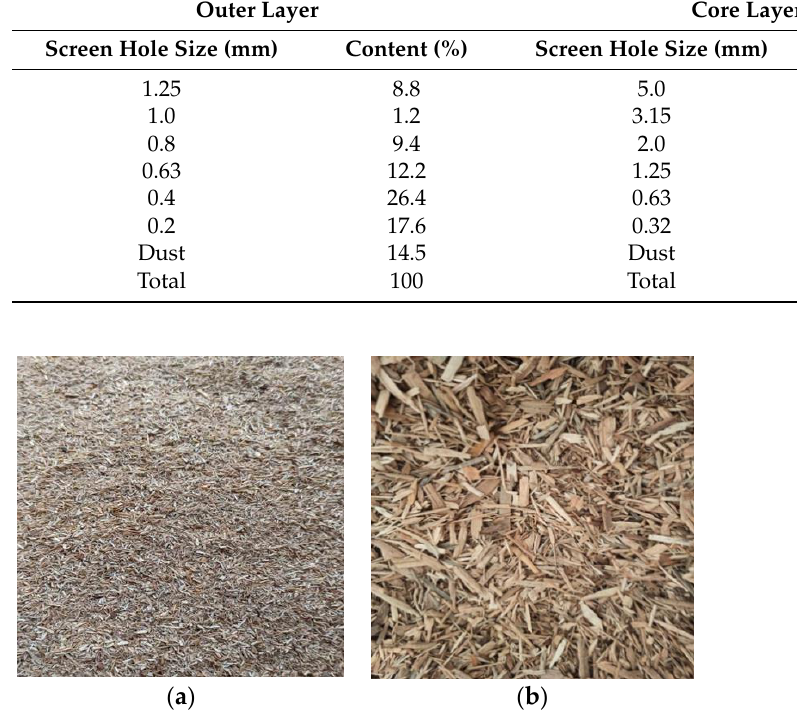
Table 1. Fraction analysis (by % weight) of particles.